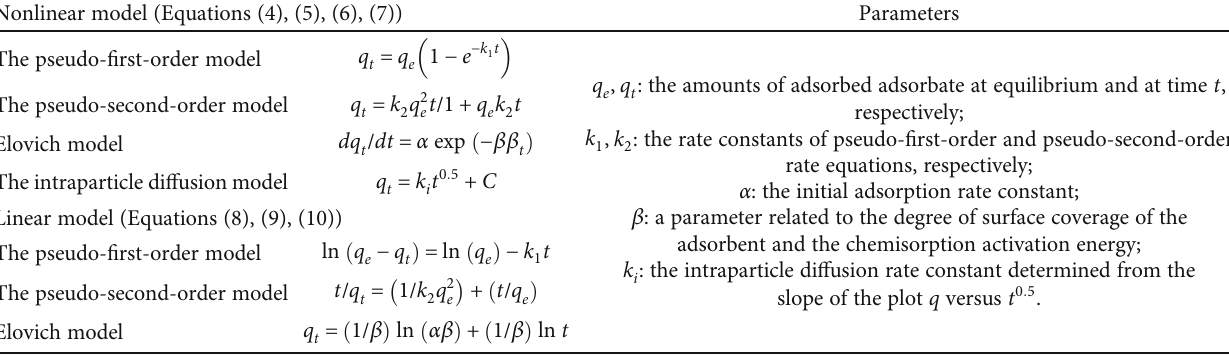
Table 1: Sorption kinetic model expressions and parameter de fi